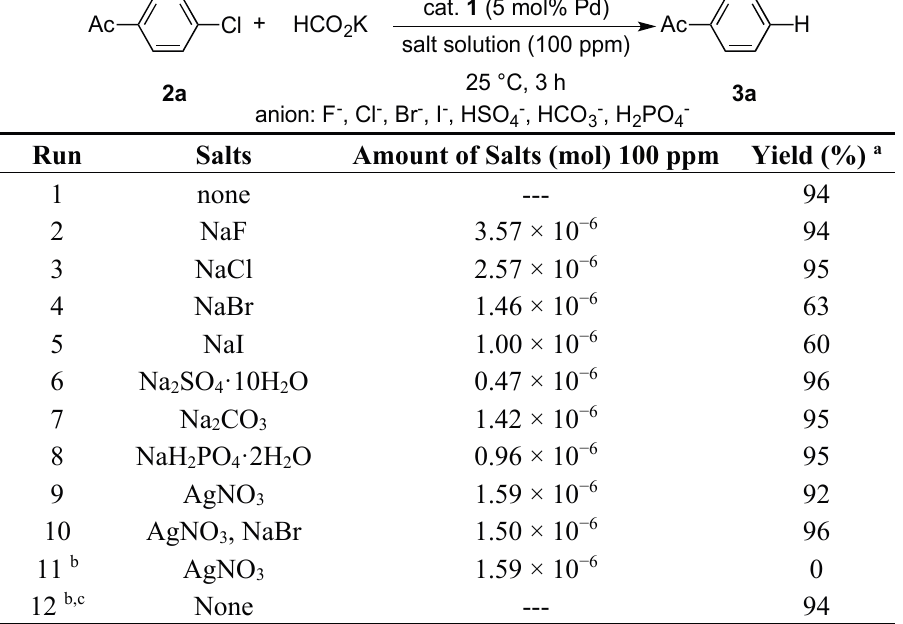
Table 2. Ionic influence on hydrodechlorination in water using polymeric catalyst 1 .